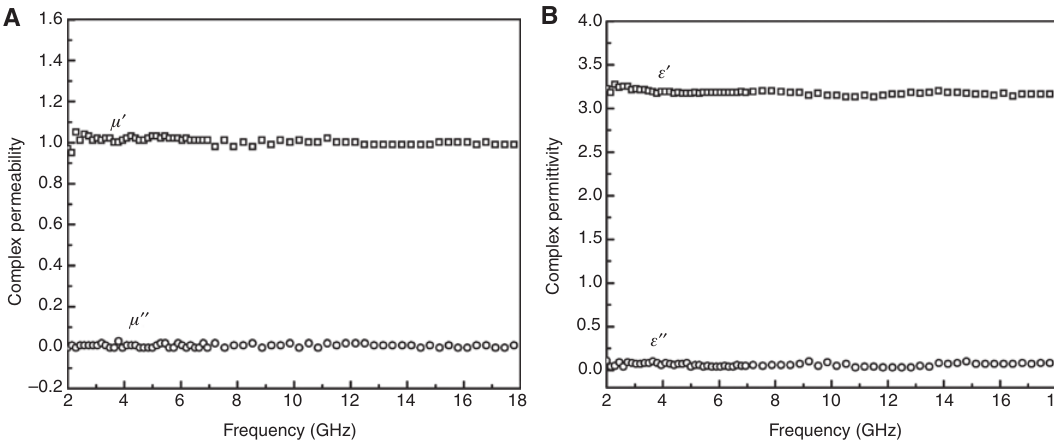
Figure 3: Complex permeability (A) and complex permittivity (B) of FA in 2–18 GHz